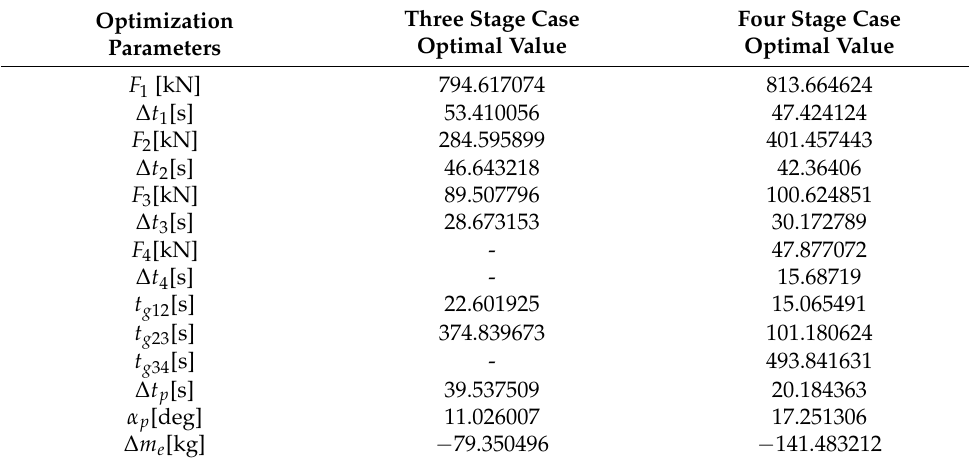
Table 3. Optimal values of design variables of the air-launched solid base